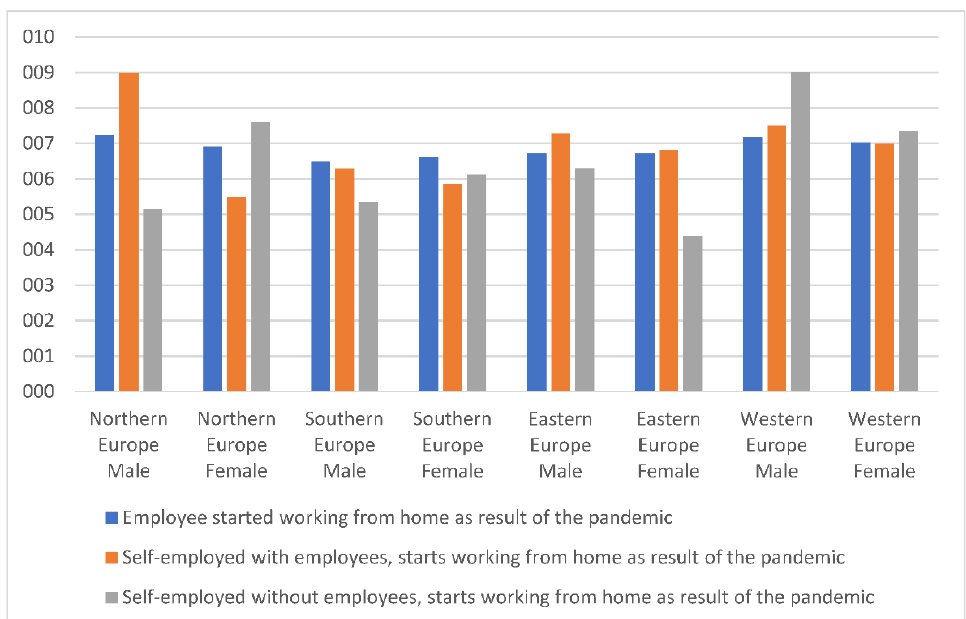
Figure 1. Life satisfaction of men and women teleworkers, employment status across European regions. Source: Own elaboration based on Eurofound data.